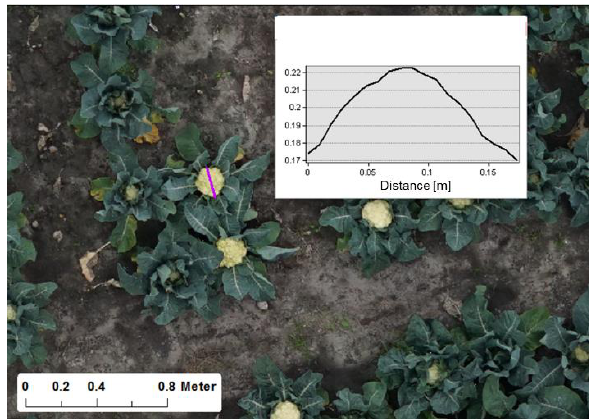
Figure 8: Example of a strongly curved cauliflower head, determined from the detailed crop height model